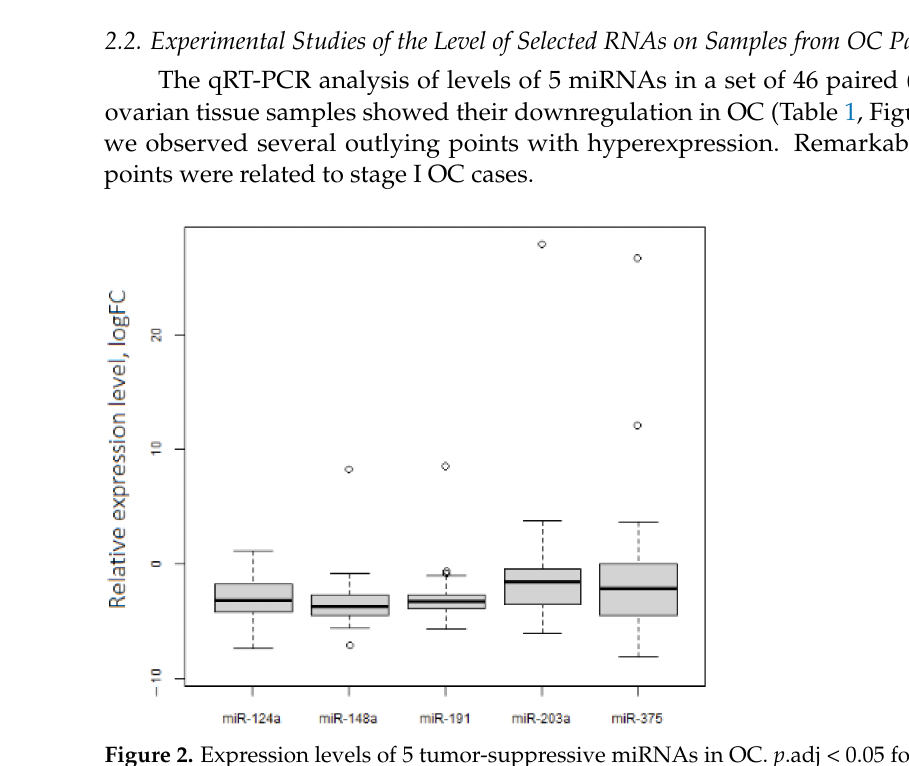
Figure 2. Expression levels of 5 tumor-suppressive miRNAs in OC. p .adj < 0.05 for each